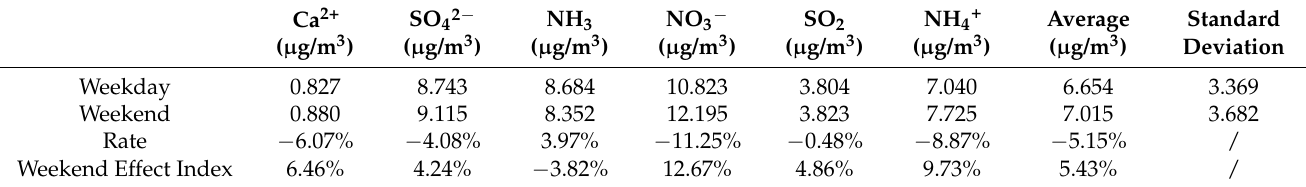
Table 3. Changes in the concentration of water-soluble ions on weekdays and weekends from 2016 to